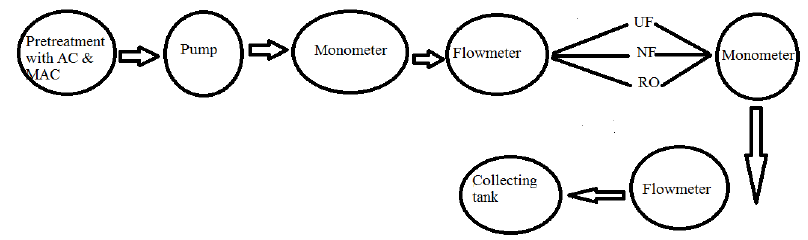
Figure 2. Schematic diagram of pilot plant.